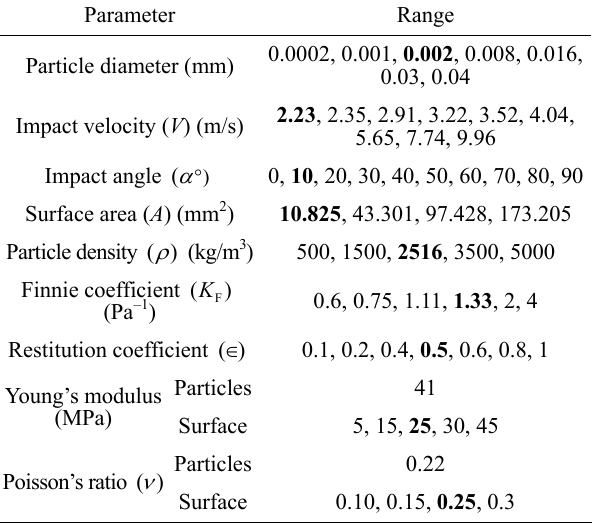
Table 1 Range of parameters in the single-particle model (reference values are presented in